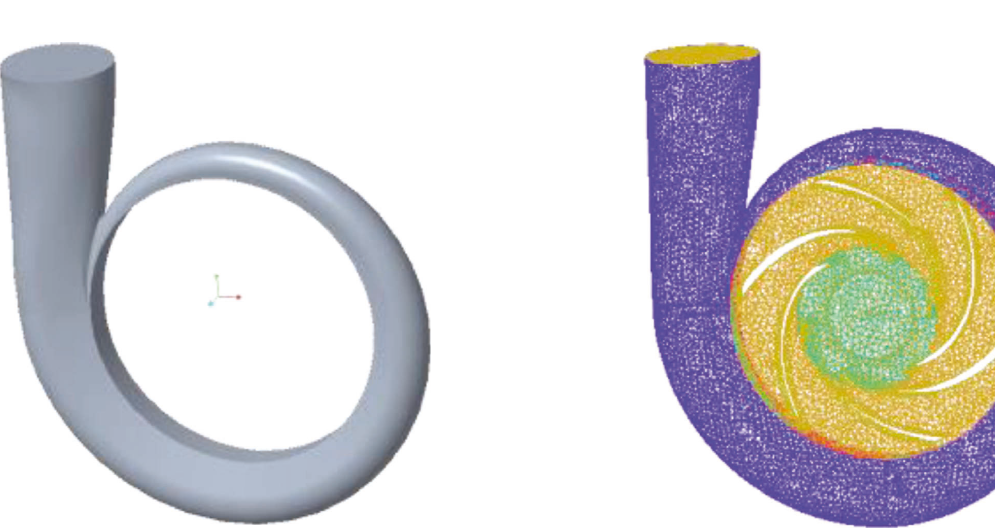
Figure 7: Hydraulic grid of the plastic centrifugal pump.